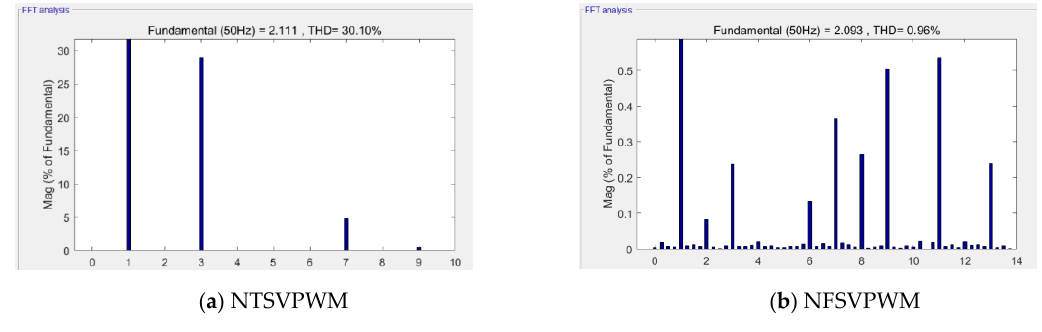
Figure 25. Harmonic characteristics at m = 1.0514.